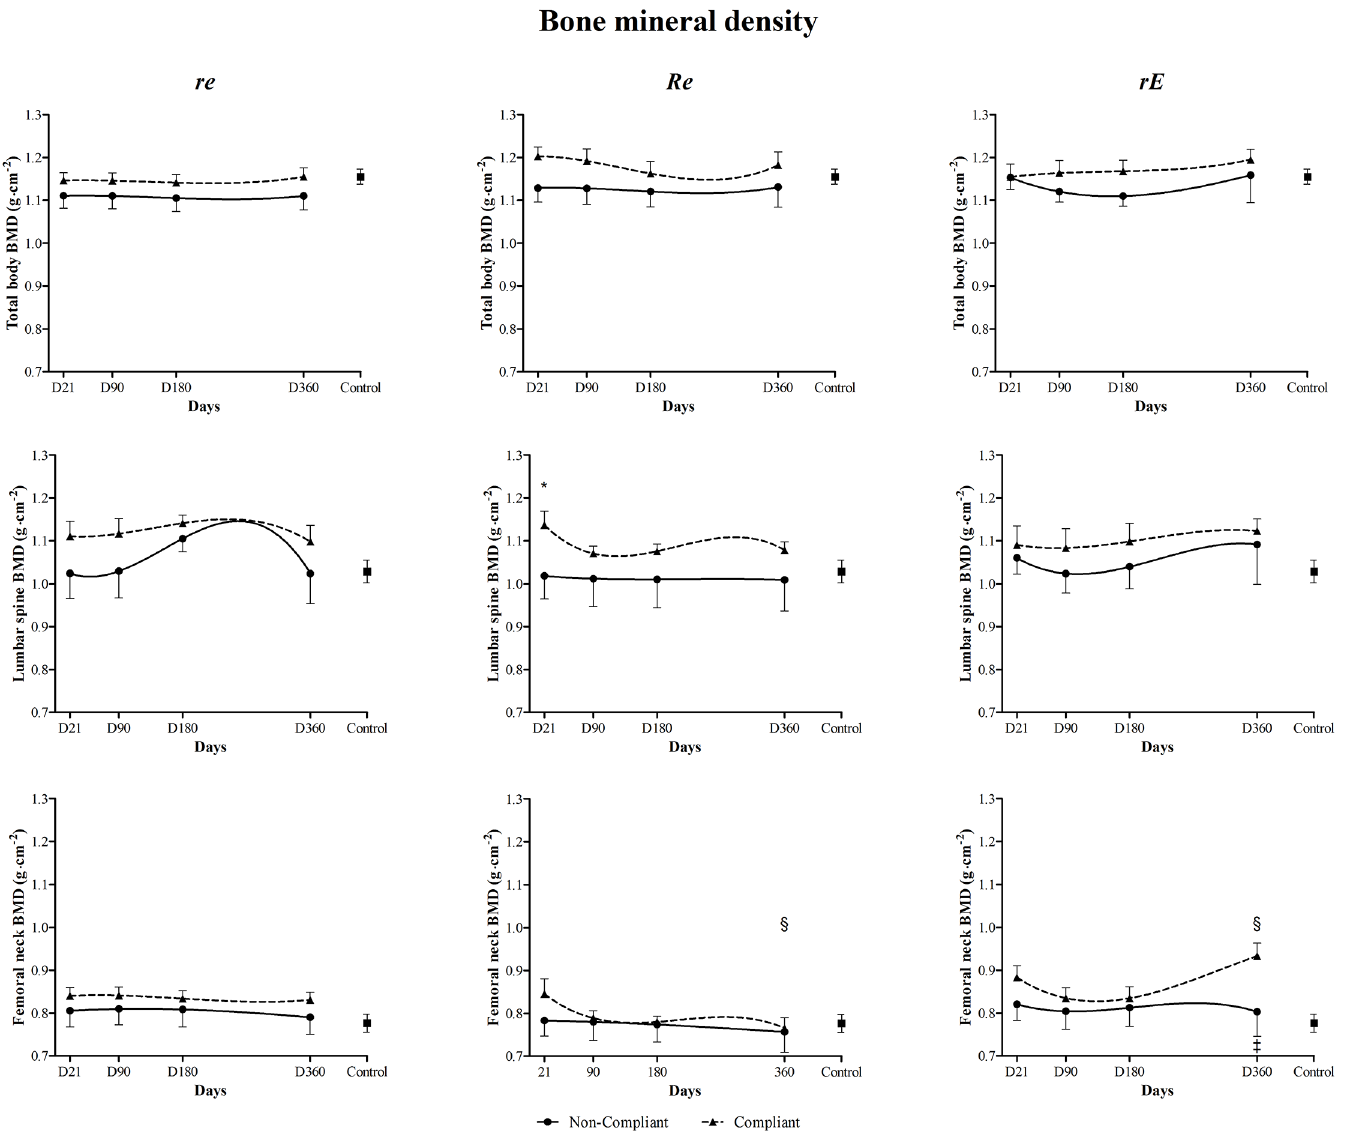
Fig 4. Compliance effect (360 days) on total body bone mineral density (BMD), lumbar spine BMD and femoral neck BMD for re , Re and rE groups. re : moderate-resistance-moderate-endurance; Re : high-Resistance-moderate-endurance; rE : moderate-resistance-high-Endurance. * Compliant participants significantly different from non-compliants (p < 0.05). ‡ Compliant participants significantly different from controls. § Significant difference Re compliants vs. rE